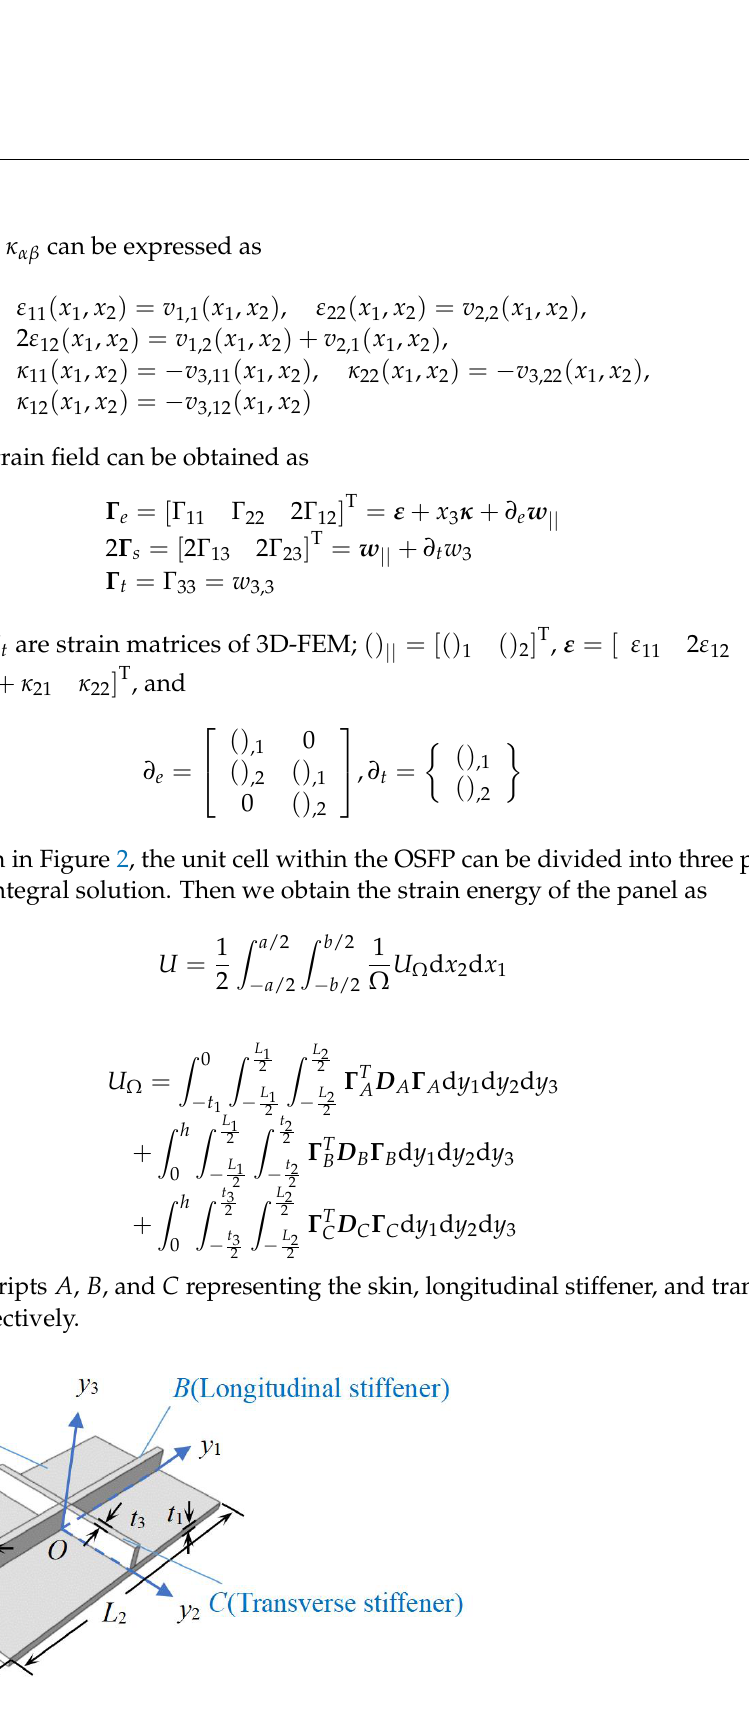
Figure 2. Decomposition diagram of unit cell within the